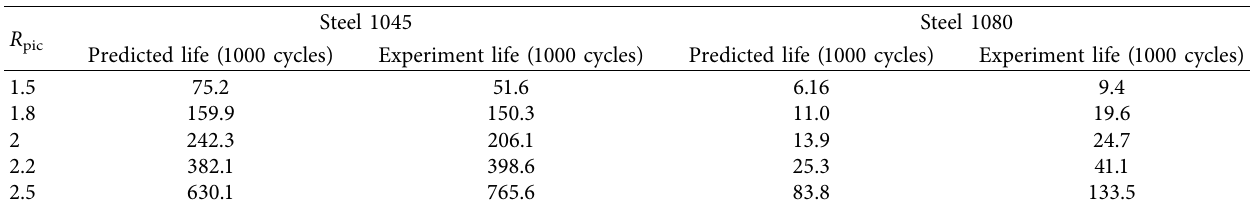
Figure 8: Estimated FCG rate curve with diferent R pic for steel 1045 (a) and 1080 (b). Table 3: Predicted and experimental fatigue life for steel 1045 and